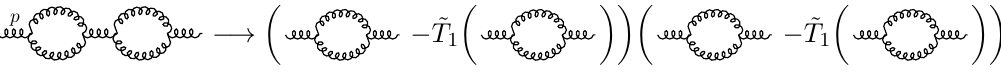
Figure 7. Soft subtraction for two consecutive gluonic self-energy corrections. The two 1PI subgraphs result in an R -style subtraction once the product above is expanded. In this form shown however, the correct scaling of the subtracted quantity is manifest: the subtracted consecutive self- energy scales like a single propagator would in the soft